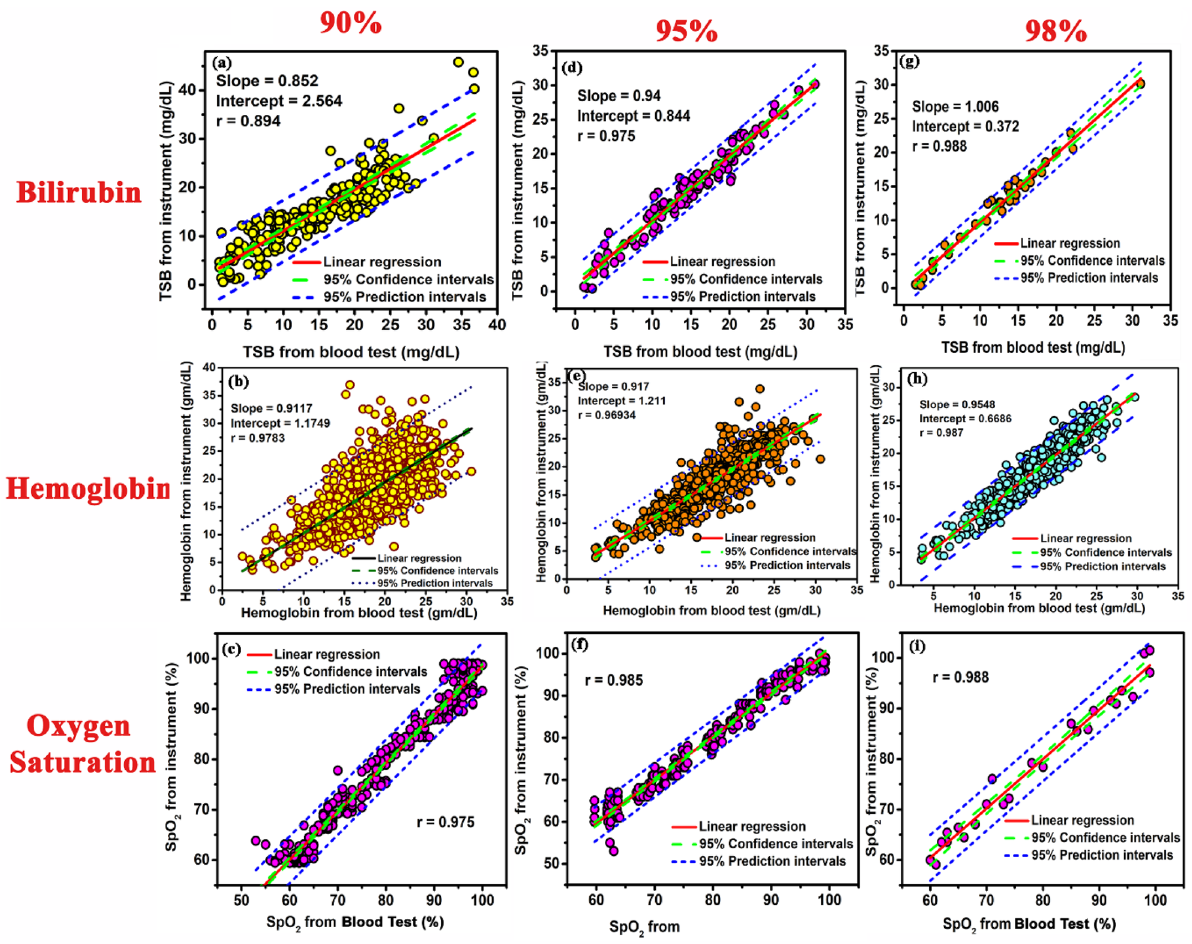
Figure 4. Validation of the instrument in different partitions of the dataset. Linear regression plot of the developed device verses TSB on 230 neonates, when ( a ) 90% of the acquired data points are scattered within ± 0.02% from the cumulative fitted curve in the residual plot. ( d ) 95% of the acquired data points are scattered within ± 0.02% from the cumulative fitted curve in the residual plot. ( g ) 98% of the acquired data points are scattered within ± 0.02% from the cumulative fitted curve in the residual plot. Linear regression plot of the developed device verses Hb on 1073 neonates, when ( b ) 90% of the acquired data points are scattered within ± 0.02% from the cumulative fitted curve in the residual plot. ( e ) 95% of the acquired data points are scattered within ± 0.02% from the cumulative fitted curve in the residual plot. ( h ) 98% of the acquired data points are scattered within ± 0.02% from the cumulative fitted curve in the residual plot. Linear regression plot of the developed device verses SpO 2 on 340 neonates, when ( c ) 90% of the acquired data points are scattered within ± 0.02% from the cumulative fitted curve in the residual plot. ( f ) 95% of the acquired data points are scattered within ± 0.02% from the cumulative fitted curve in the residual plot. ( i ) 98% of the acquired data points are scattered within ± 0.02% from the cumulative fitted curve in the residual